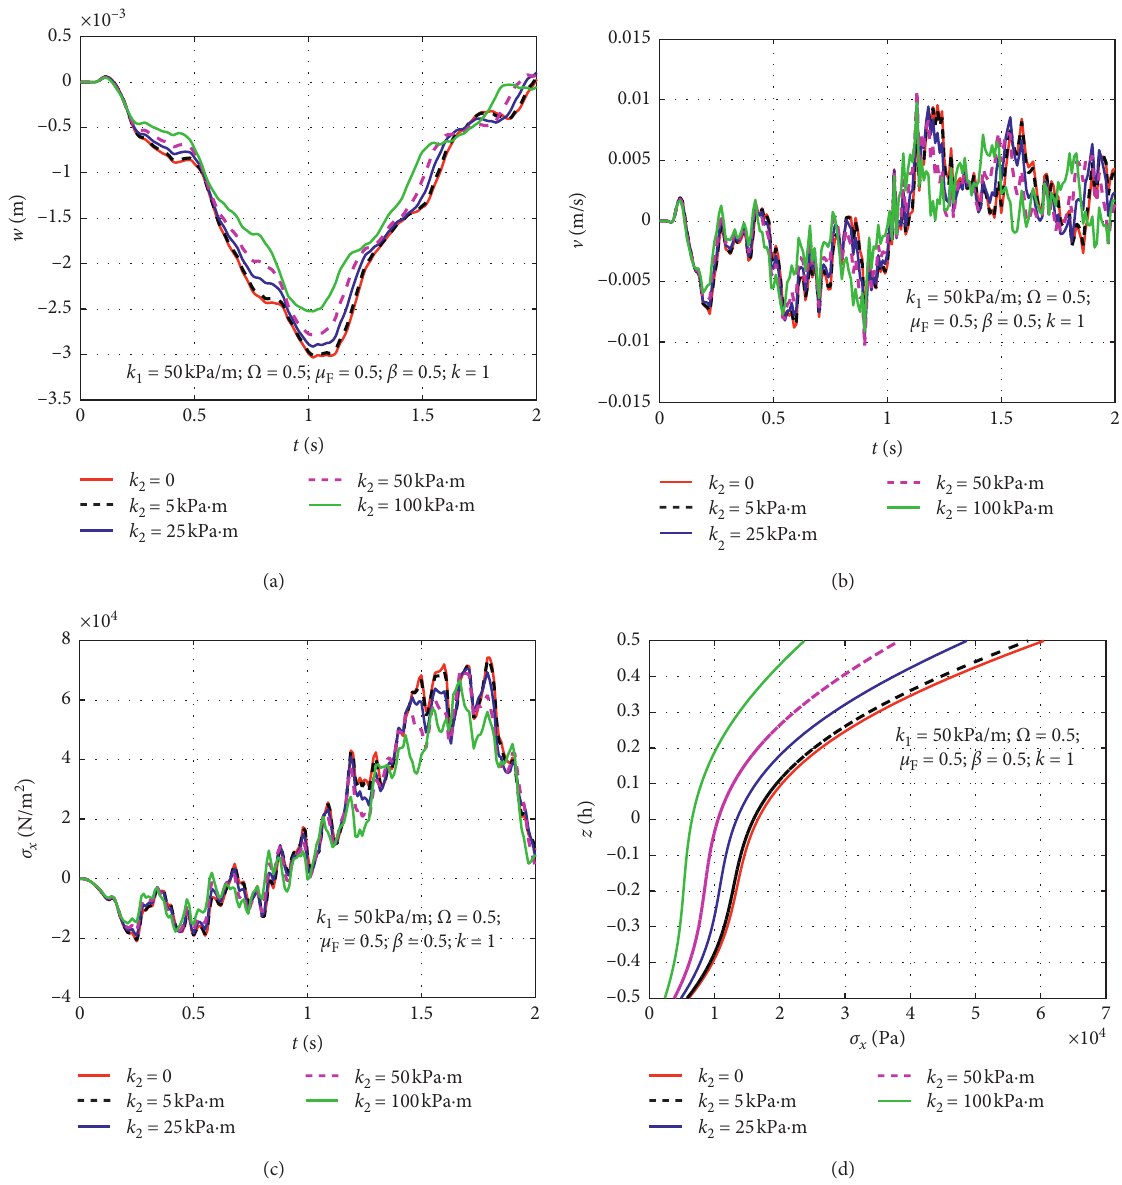
Figure 11: The responses of deflections, velocities, and stresses at the central point of the plate versus time with the variation of the foundation stiffness k : (a) deflection w versus time; (b) velocity v versus time; (c) stress σ x versus time; (d) stress σ x through thickness. 2 Table 7: Maximum deflections, velocities, and stresses at the central point of the FGP plate versus time. Maximum